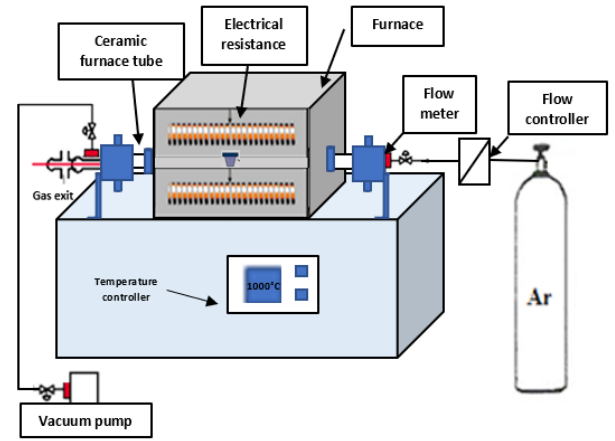
Figure 1. A schematic of the experimental growth procedure.